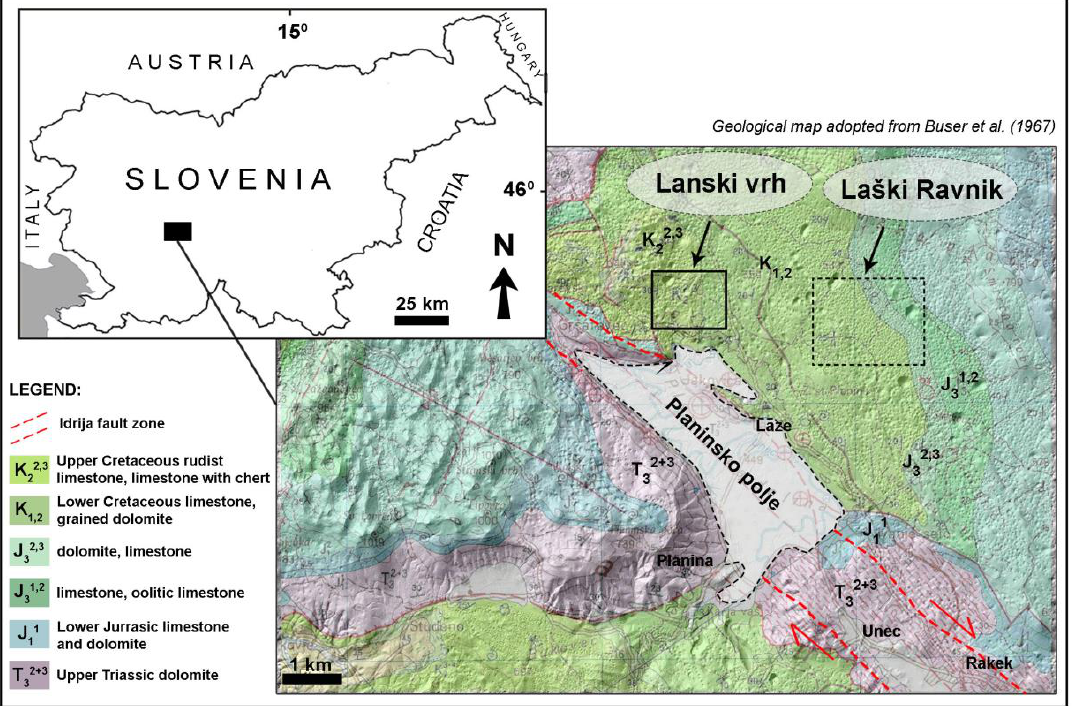
Figure 1. Location of the study area Lanski vrh and the basic geology [27] with the selected lithostratigraphic units of the narrow area on the LiDAR shaded relief image [28].